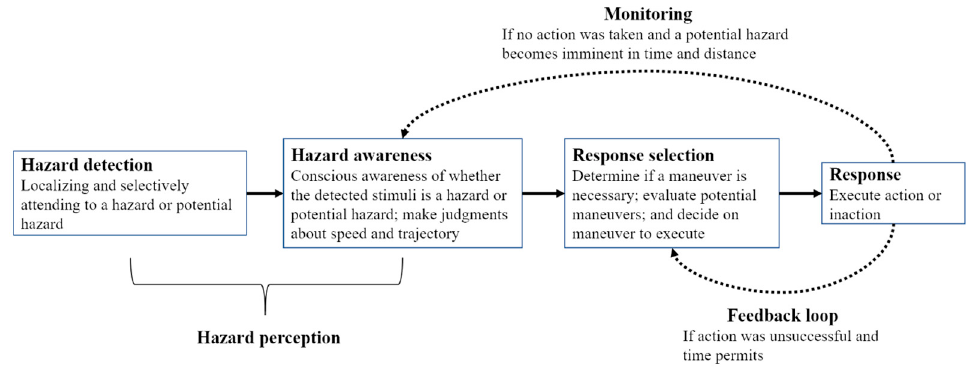
Figure 1. Hazard perception–response framework.